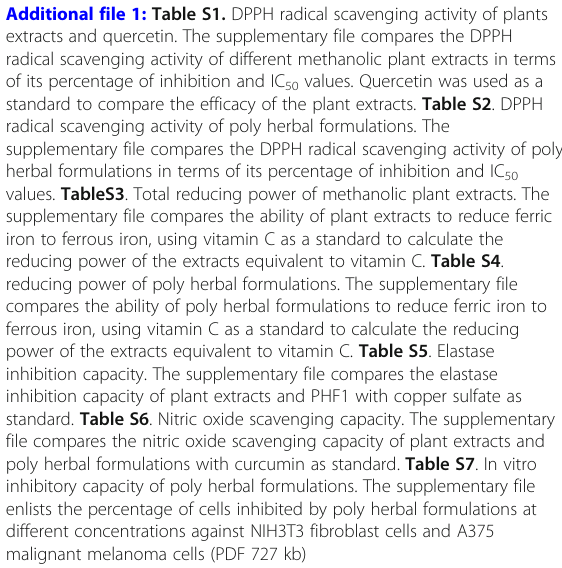
poly herbal formulations with curcumin as standard. Table S7 . In vitro inhibitory capacity of poly herbal formulations. The supplementary file enlists the percentage of cells inhibited by poly herbal formulations at different concentrations against NIH3T3 fibroblast cells and